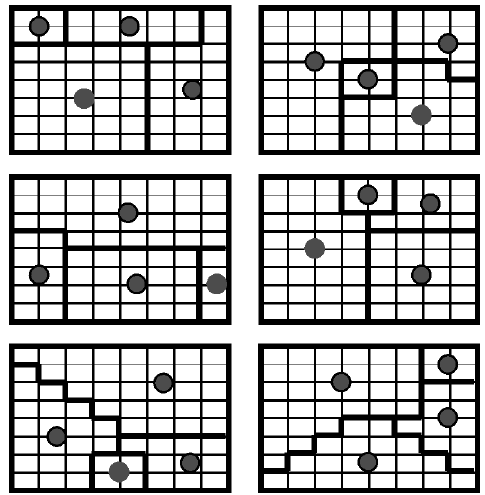
FIGURE 2 Substrate division chosen out of dozens of cases. Placement of four heat sources dissipating 0.4, 1, 2 and